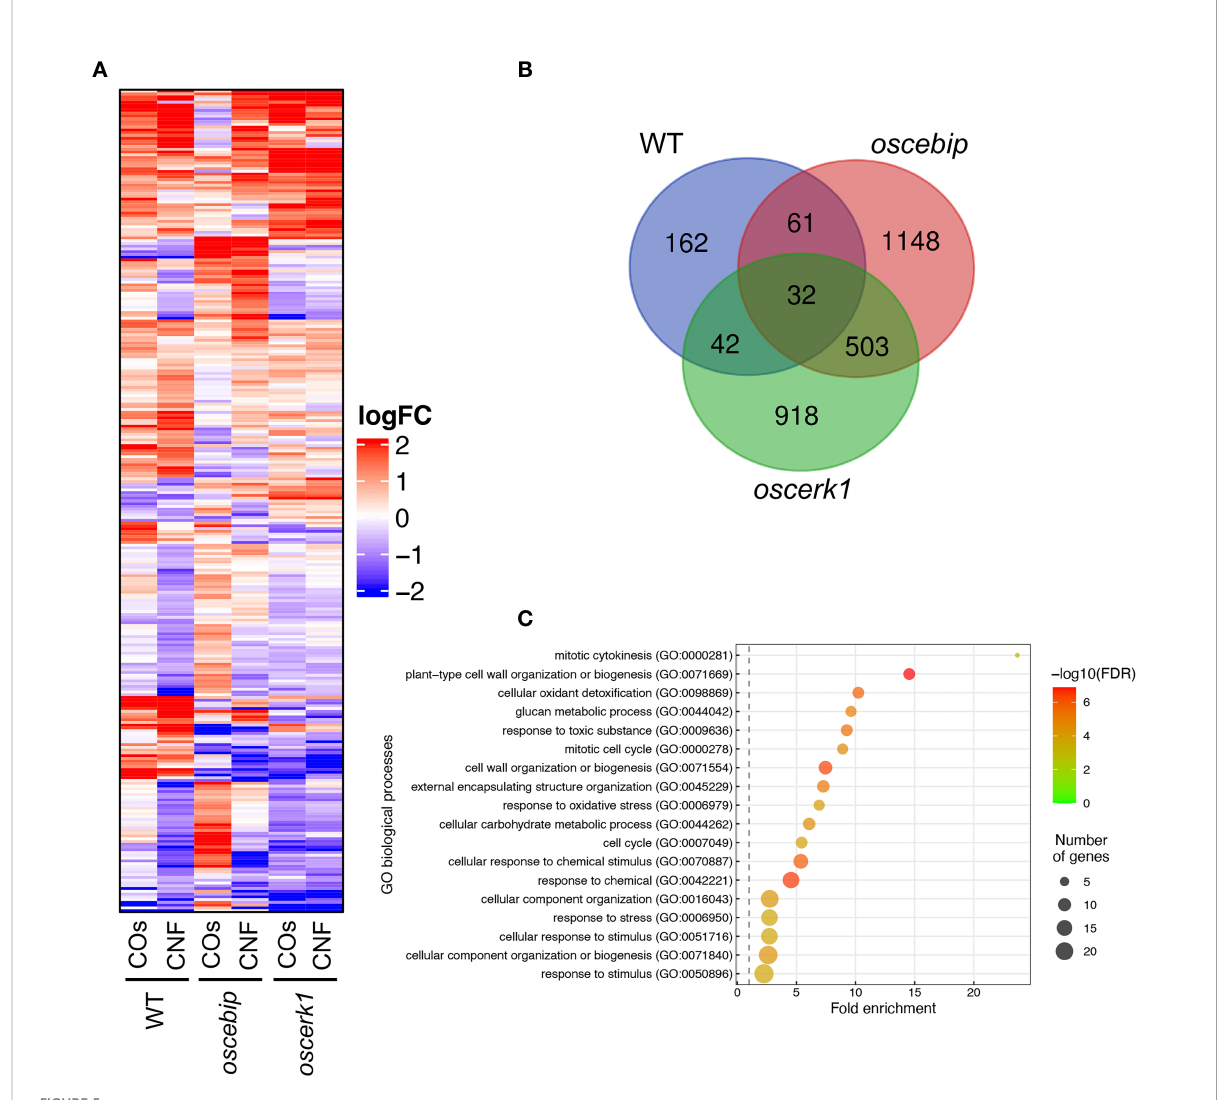
FIGURE 5 Transcriptome analysis of leaves from LysM-receptor mutants grown on chitin-supplemented soils. (A) Heatmap representation of expression levels of genes identi fi ed in the wild type (WT) as being differentially expressed in leaves upon chitin treatment and listed in Supplementary Table 2 and 3 in the leaves of the WT and oscebip or oscerk1 mutants. LogFC is shown between − 2 and 2, with outside values indicated as 2 or − 2. Red, upregulated; blue, downregulated. (B) Venn diagram showing the overlap between chitin-induced DEGs in the WT and genes that were DEGs in the knockout mutants (blue: in the WT, red: in oscebip mutants, green: in oscerk1 mutants). (C) Results of GO enrichment analysis of the genes not differentially expressed in oscebip and oscerk1 mutants de fi ned above [162 genes; in the WT-speci fi c group of (B)